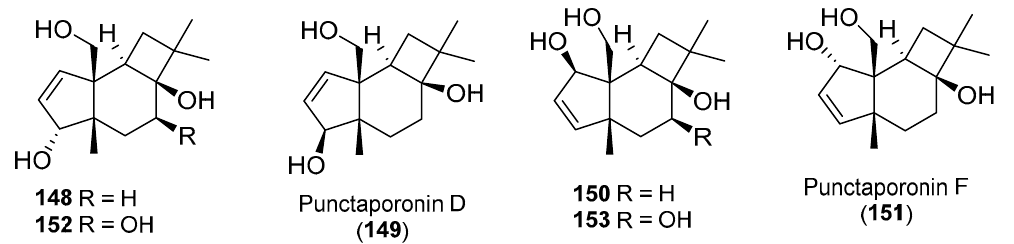
Figure 23. Structures of punctaporonins 148 – 153 isolated from the Poronia and Pestalotiopsis genera of fungi.